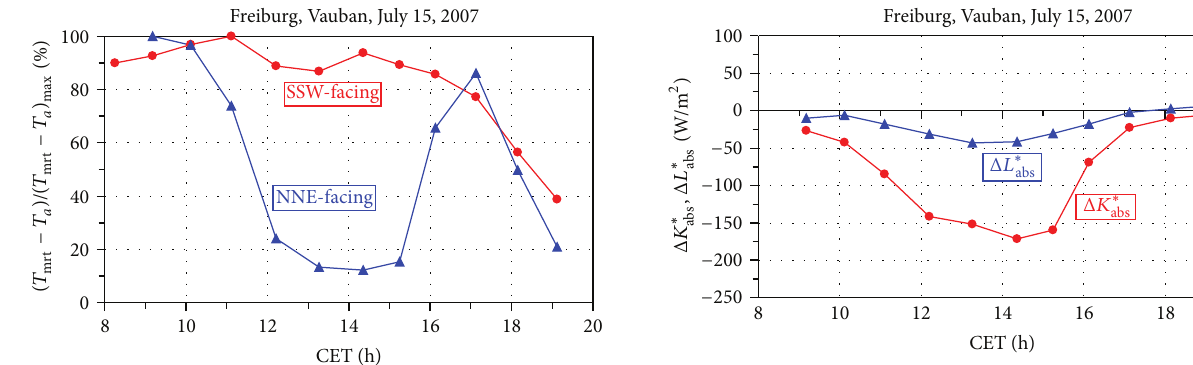
Figure 12: 1h mean values of the difference between mean radiant andairtemperature 𝑇 𝑎 ,relatedtothe1hpeakvalue temperature 𝑇 mrt − 𝑇 of ( 𝑇 𝑎 ) at the shaded NNE-facing sidewalk ( mrt 26.4 ∘ C) and sunny SSW-facing sidewalk ( (𝑇 of a WNW-ESE street canyon, “Vauban” quarter in Freiburg during typical Central European summer day.